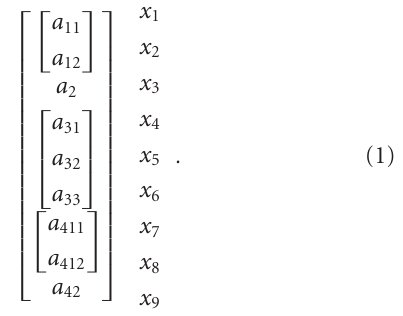
Figure 4: A sample path to the